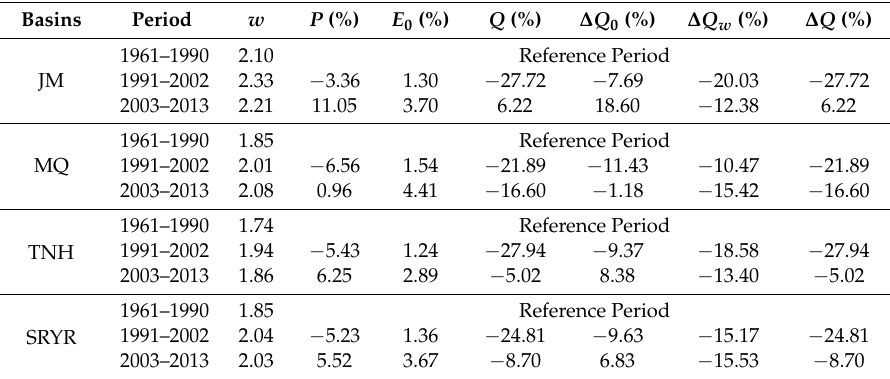
Table 1. Results of decomposition